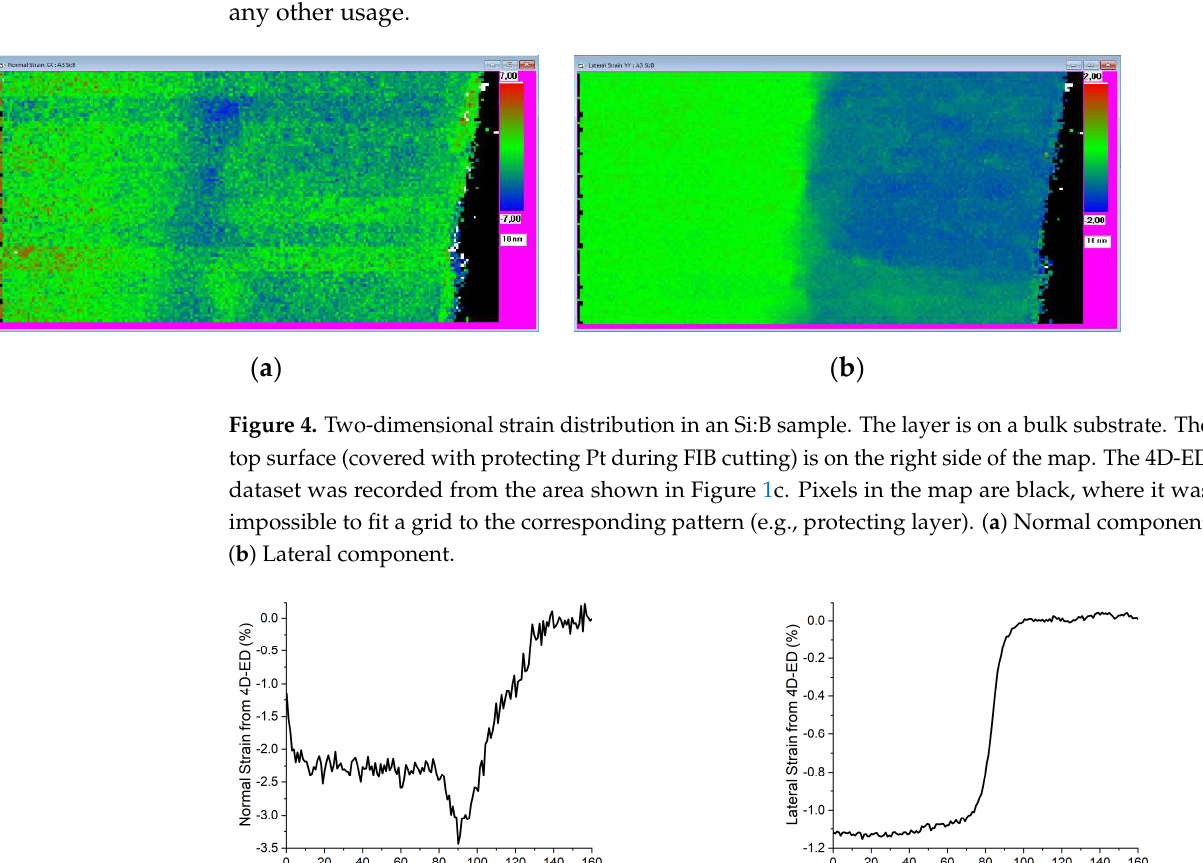
Figure 5. One-dimensional strain distribution in an Si:B sample as a function of depth. ( a ) Normal component. ( b ) Lateral component.